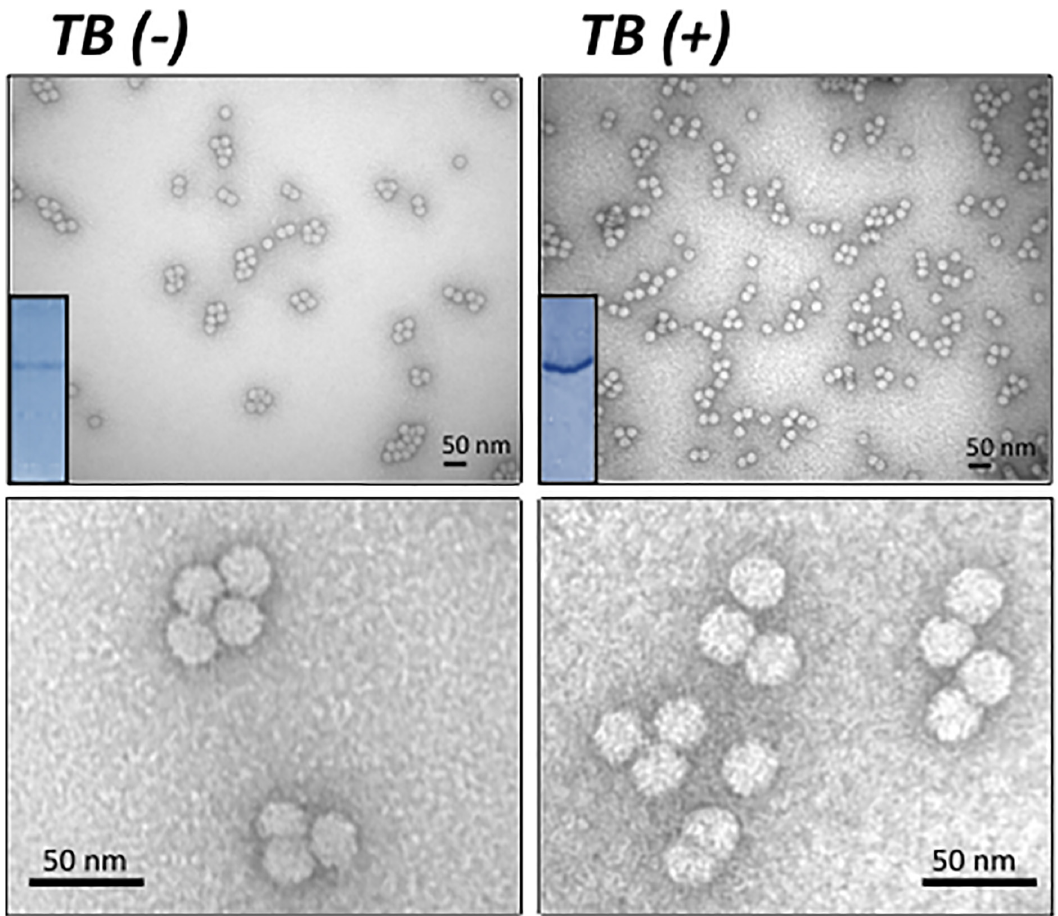
Fig 4. VLPs formed after infection of Sf9 cells with a conventional TB(-) or a TB (+) baculovirus expressing the ORF2 from porcine circovirus. Extracts from infected cells at the optimal production times with each baculovirus were processed for VLP purification. The protein patterns of the purified VLPs obtained with each baculovirus are shown in the inserts (Coomassie blue stained). Samples were observed by Electron microscopy using negative staining. The figure shows the VLPs at two magnifications. VLPs obtained with the two baculoviruses presented identical sizes and shapes but were more abundant when produced by the TB(+) virus. The micrographs are representative of the fields